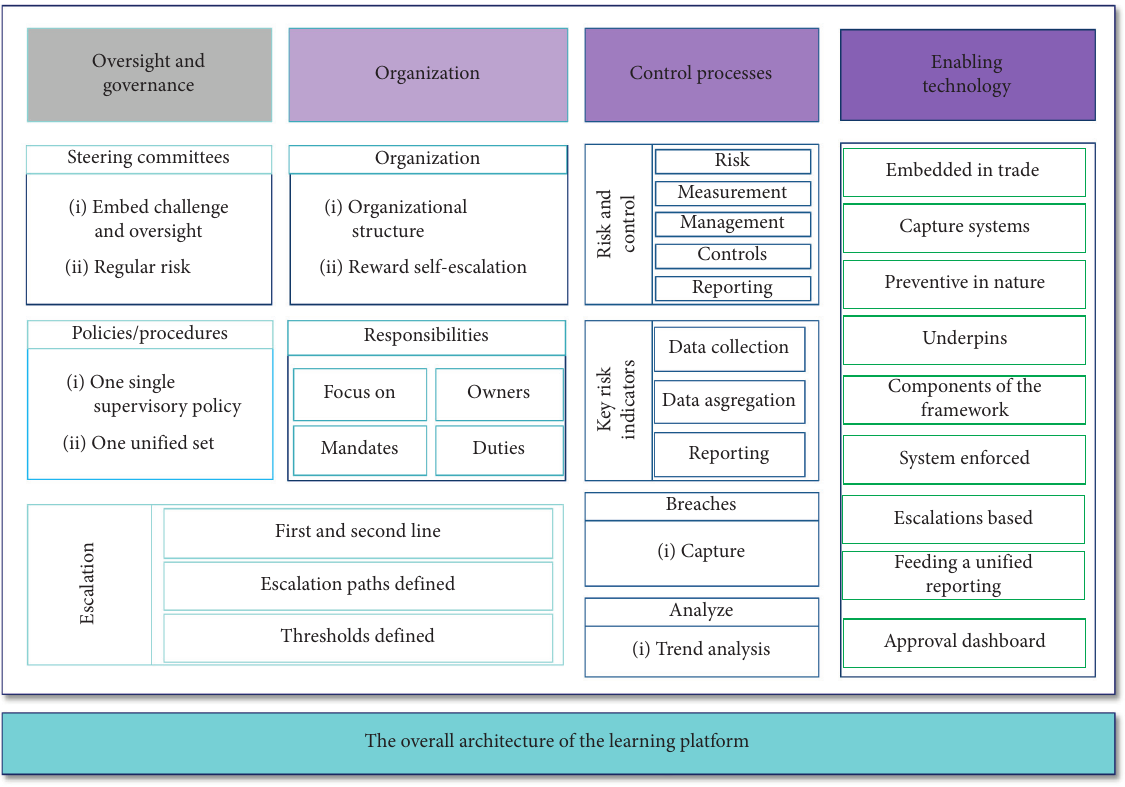
Figure 2: The overall architecture of the learning platform.